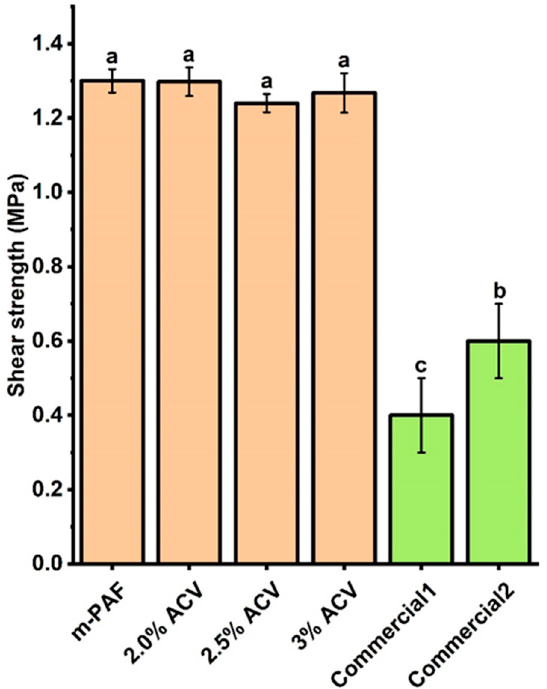
Figure 7. Shear strengths of the m-PAF and ACV/m-PAF adhesives at various ACV concentrations. Group classi fi cation (a, b, and c) was given to the data based on the statistical analysis results (sig- ni fi cant di ff erence; p ≤ 0.05). Green bar graphs are given for the results from commercially available water glues.